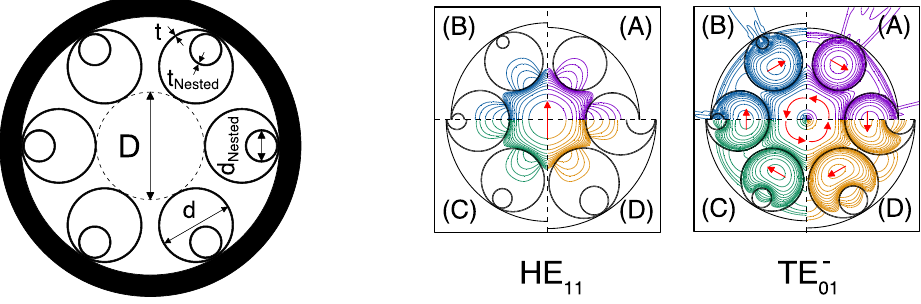
Figure 1. Left: Sketch of the Nested Antiresonant Node-less Fiber (NANF) cross-section, with its key parameters. Glass is marked in black and the hollow regions in white. Right: 3-dB contour plots of the HE 11 fundamental modes and hybrid TE − modes at the avoided crossing point, for different values of 01 d Nested / d equal to 0.00 (A), 0.20 (B), 0.30 (C) and 0.40 (D) respectively. The color code used is identical to that in Figure 2. The contour plots represent the normalized electric field intensity and the red arrows indicate the polarization direction of the transverse electric field.